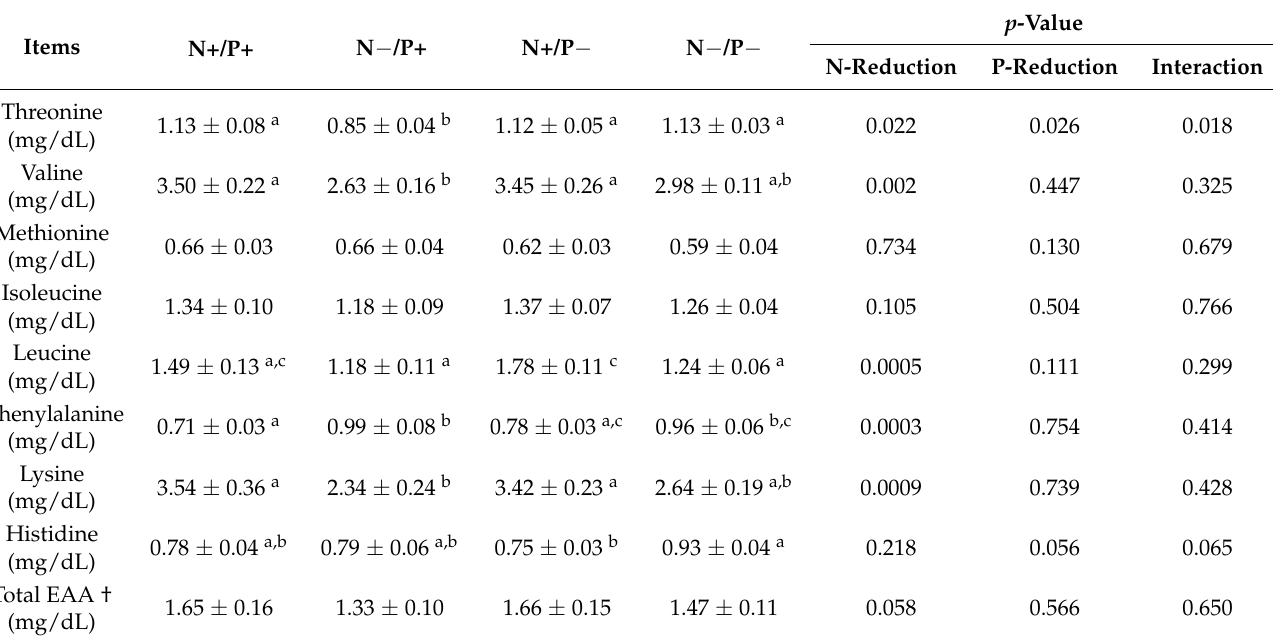
Table 4. Circulating EAA concentration in young goats fed an N- and/or P-reduced diet.